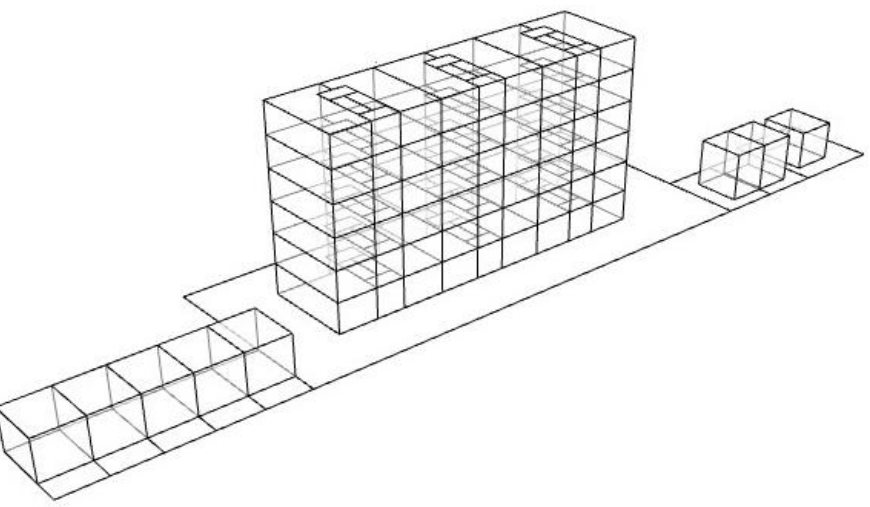
Figure 2. Skeletal model of the objects for which rights are visualized for the study. Table 1. Colors corresponding to visualized property